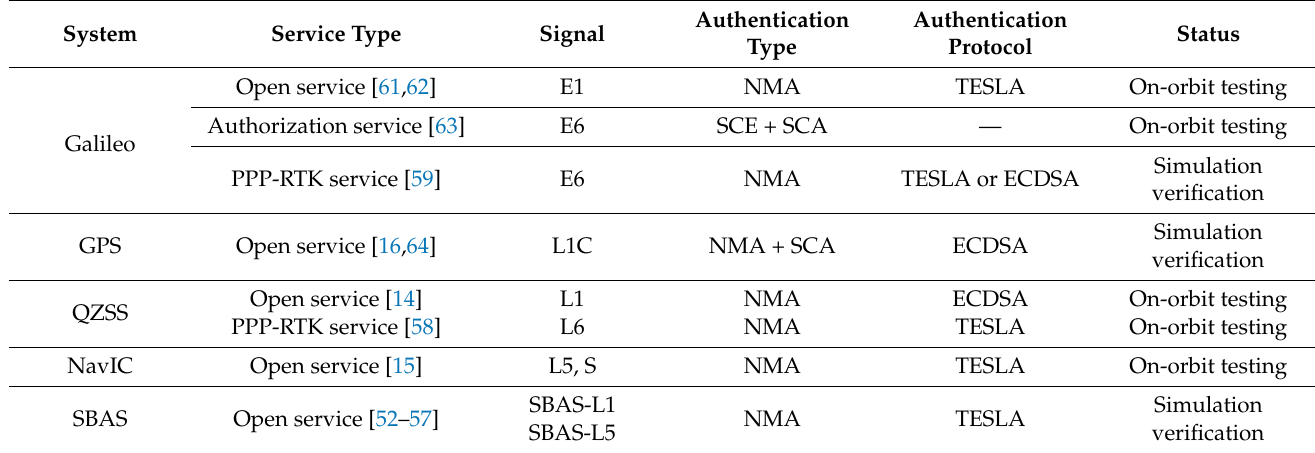
Table 5. Status of GNSS signal